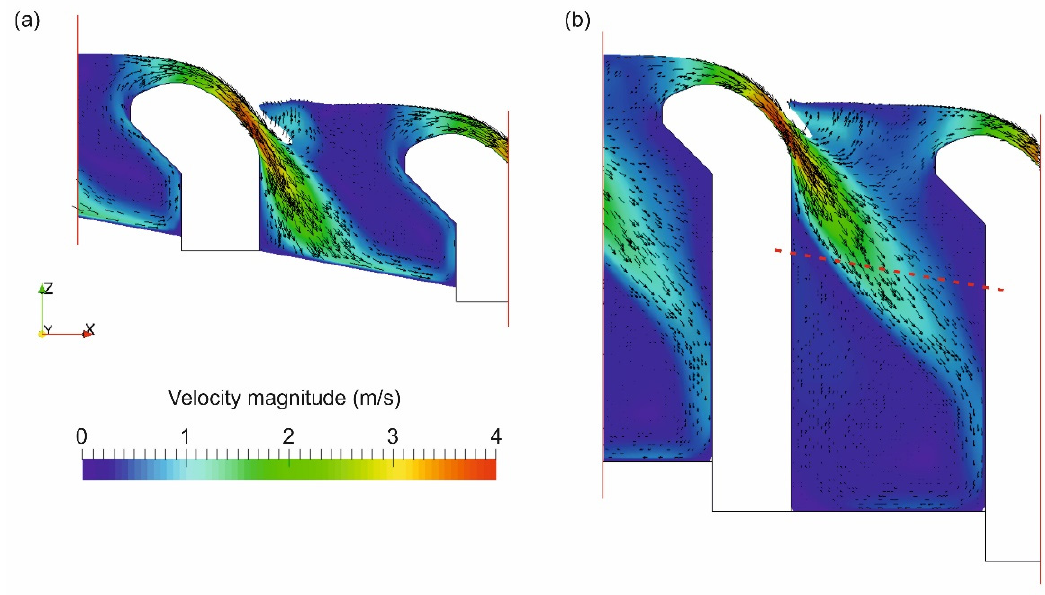
Figure 3. Numerical simulation of the fishway. ( a ) Pool depth of 1.8 m. ( b ) Pool depth of 5 m; dotted red line indicates the depth of 1.8 m.